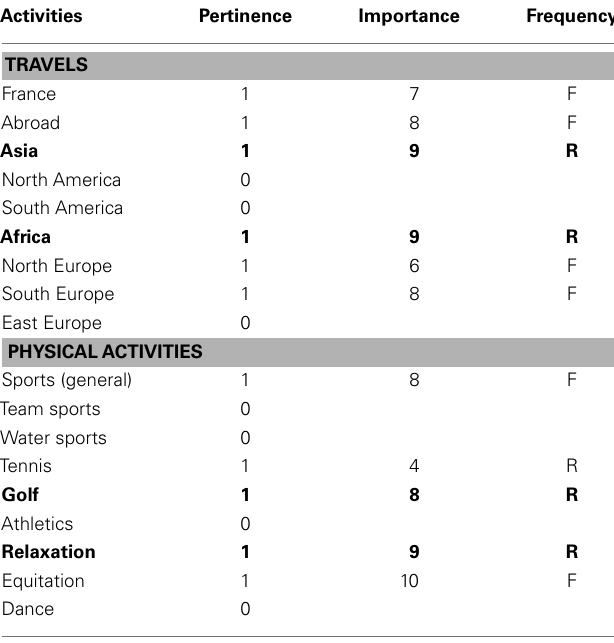
TableA1 | Excerpt of theTaste and Interest Questionnaire